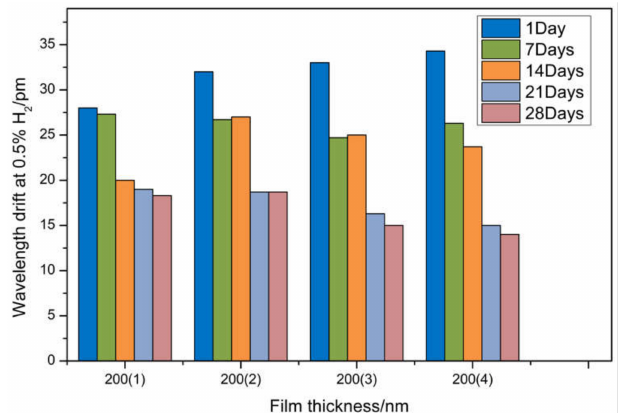
Figure 13. Wavelength drift of hydrogen sensors with different thicknesses at 0.5% H 2